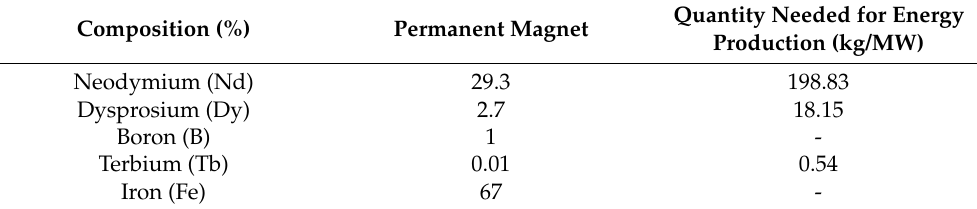
Table 6. Composition of thin-film PV